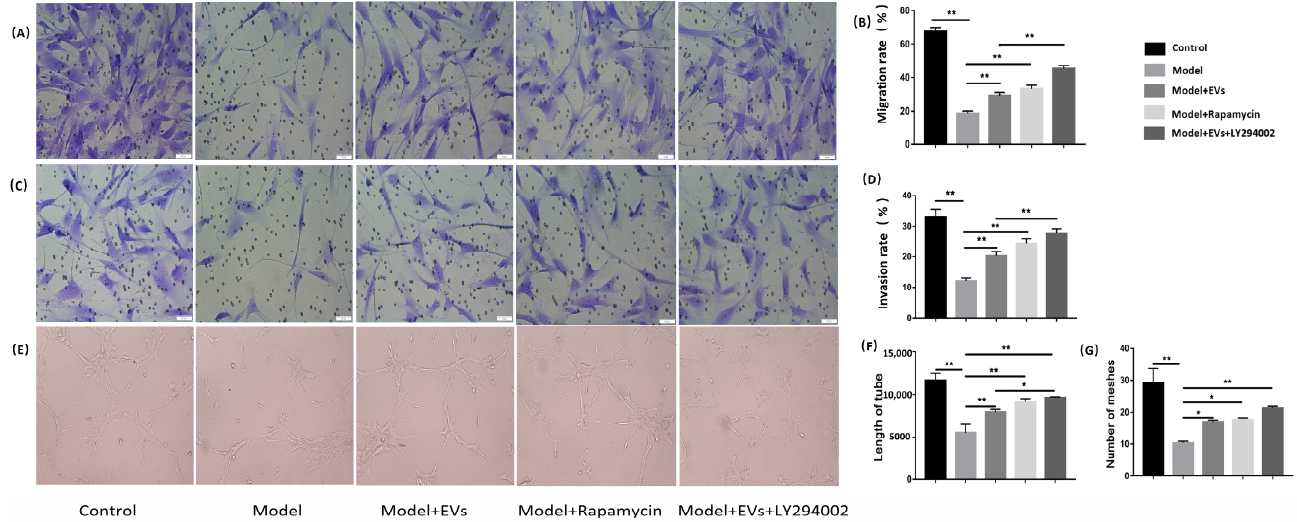
Figure 4. Angiogenesis was promoted by BMSC-EVs. ( A ) The migration capacity of BMECs was investigated by transwell assay in different groups. ( B ) Quantitative analysis of the migration rate of BMECs. ( C ) The invasion capacity of BMECs was investigated by transwell assay in different groups. ( D ) Quantitative analysis of the invasion rate of BMECs. ( E ) Tube formation assay for detecting the tube-forming ability of BMECs in the different groups. ( F , G ) Quantitative analysis of tube formation. The value of the total mesh area, total length was measured. Each bar represents the mean ± SD of three independent experiments. * P < 0.05, ** P < 0.01.